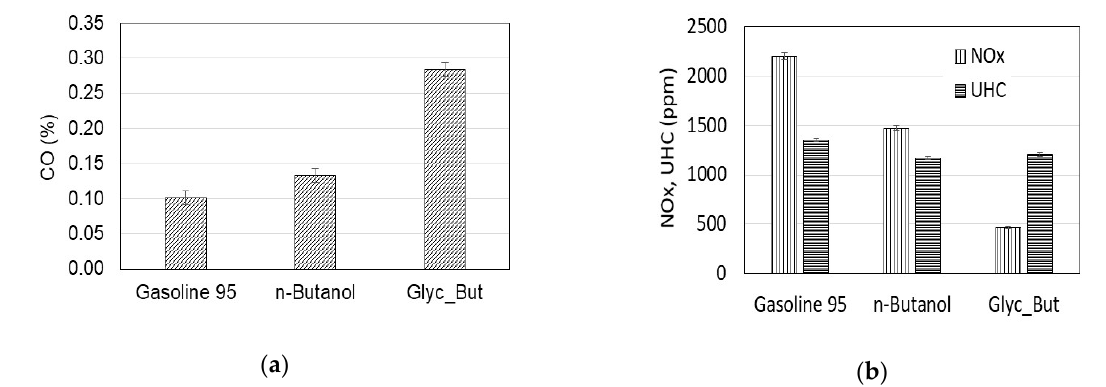
Figure 9. ( a ) CO; ( b ) NOx, and UHC emissions at optimal spark timings for gasoline, butanol, and Glyc_But fuels.